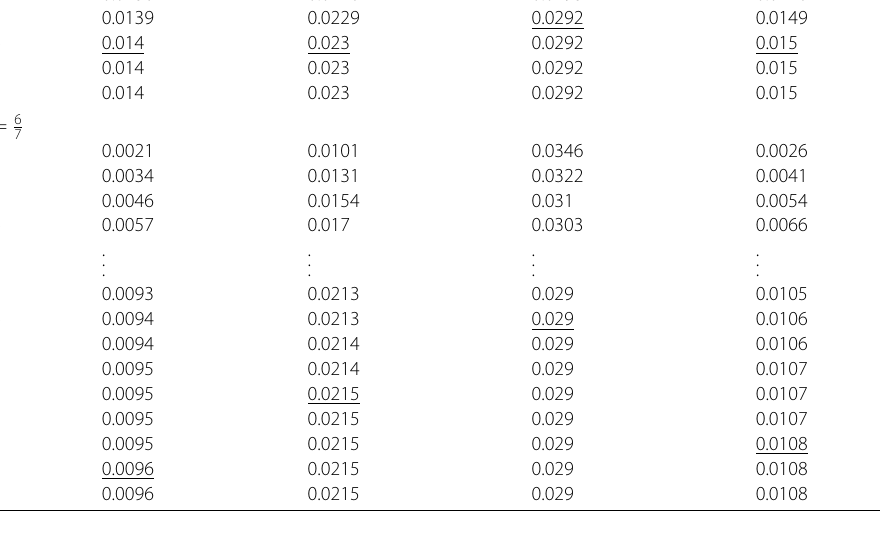
Table 9 Some numerical results of I α q [ m 3 ]( t ), I α –1 q [ m 3 ](1), I α –2 q [ m 3 ]( b ), and I α – ζ q [ m 3 ]( t ) in Example